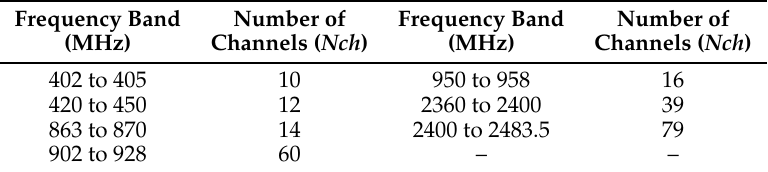
Table 1. The number of channel resources at each